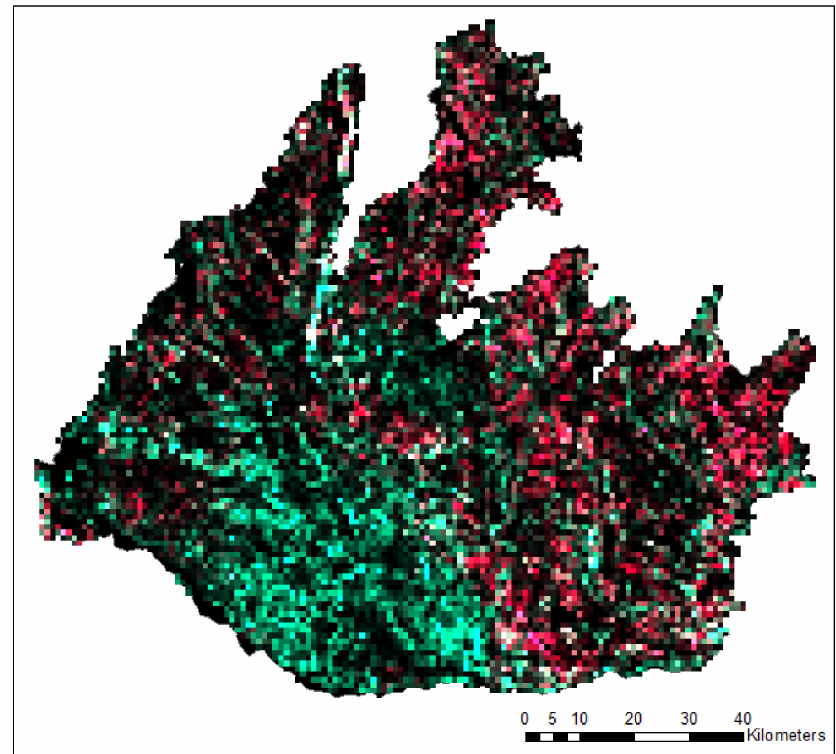
Figure 13. Proportion of black locust in 1 × 1 km window. RGB composition; red band represents proportion of black locust in SWF in 1 km 2 ; green band represents proportion of native vegetation in SWF in 1 km 2 ; blue band was not used.